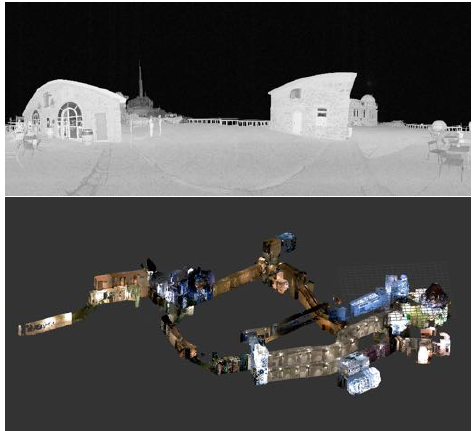
Figure 4. Top : Example of exterior scan of the terrace and buildings — Bottom : A sample of the interior scan of the buildings